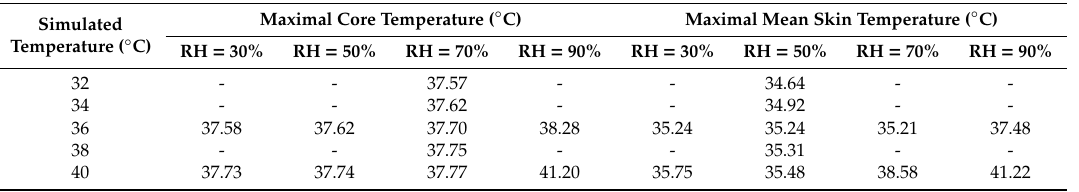
Table 2. Maximal core temperature and mean skin temperature observed in various studied simulation